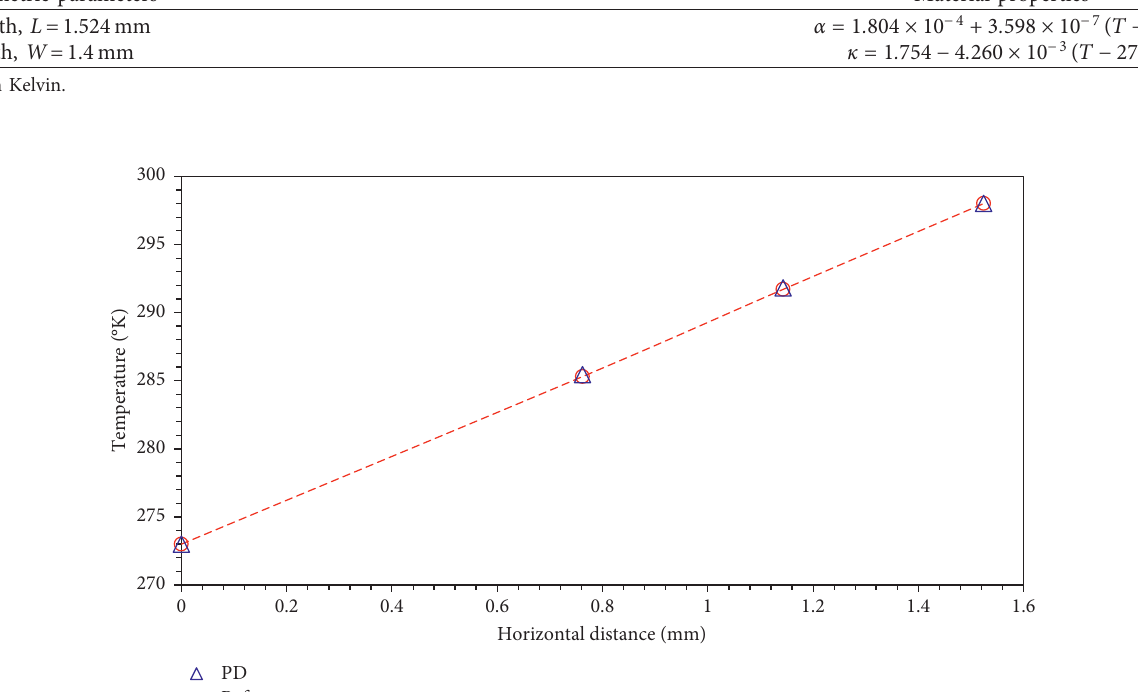
Figure 20: Comparison of temperature values in case of temperature dependent material properties from PD and [90].